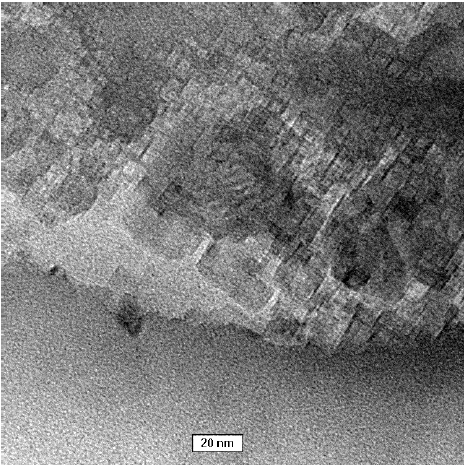
Figure 4. TEM image of CaCO 3 precipitated without protein, after 1 min.